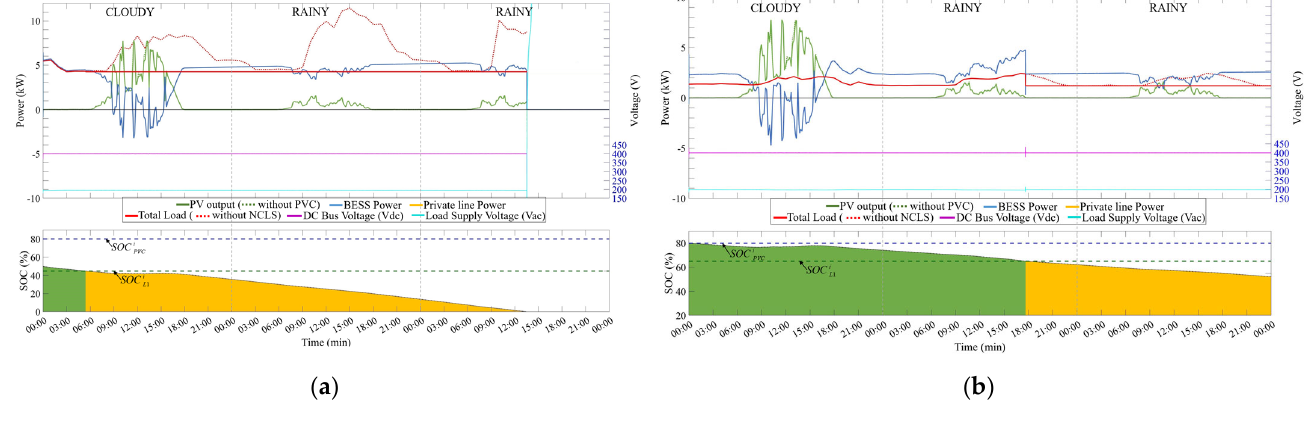
( b ) Figure 11. Test case 2 (Disconnected). ( a ) Performance of prosumer X. ( b ) Performance of prosumer Y.